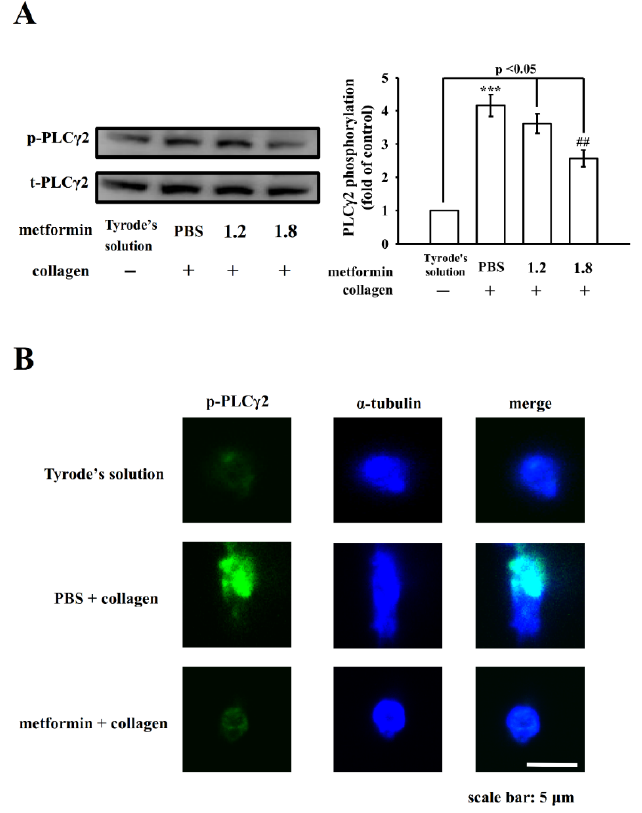
Figure 3. Effectiveness of metformin in phospholipase C γ 2 activation in platelets. Washed platelets were preincubated with PBS or metformin (1.2 and 1.8 mM) and treated with collagen (1 µ g/mL) for immunoblotting of ( A ) phospholipase C γ 2 (PLC γ 2) activation or ( B ) detecting confocal images of phosphorylated PLC γ 2 (green fluorescence) and α -tubulin (blue fluorescence) using goat anti-rabbit CF TM 488A and anti-mouse CF TM 405M Dyes, respectively. Data are presented as mean ± standard error of the mean ( n = 4). *** p < 0.001 vs. Tyrode’s solution group; ## p < 0.01 vs. PBS + collagen group. The confocal images are the representative of four independent experiments. Bar: 5 µ